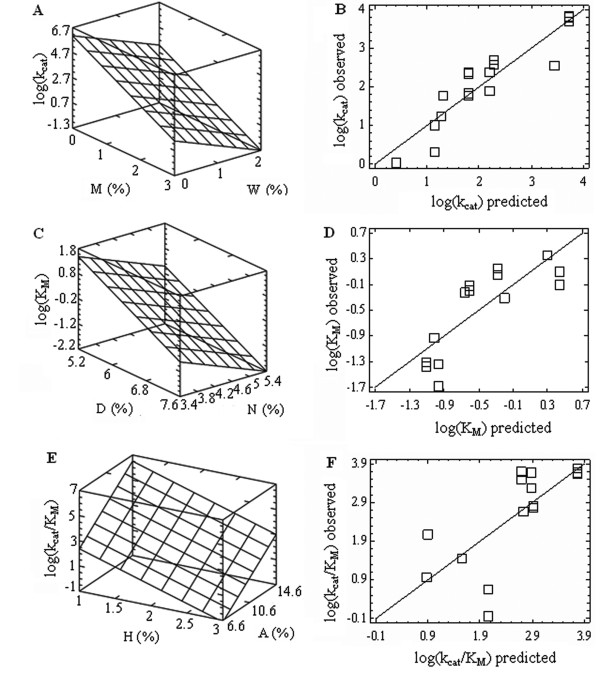
The relationships between kinetic constants and frequencies of two AA. The multiple linear regressions showing changes of the log-values of kinetic constants as dependent variables upon the frequencies of occurrence for two AA in the yeast S. cerevisiae sequences, where kcat is the catalytic constant (A), KM is the Michaelis-Menten constant (C), and ksp = kcat/KM is the specificity constant (E). The observed versus predicted plots (B,D,F) for the values of dependent variables (kcat, KM, and ksp, respectively). The predicted values were calculated from the regression equations: log(kcat) = 5.556 –1.620*M −0.984*W (Radj.2 = 82.88%, p = 0.0000); log(KM) = 8.593 –0.596*N −0.998*D (Radj.2 = 53.72%, p = 0.0039); log(kcat/KM) = 0.818 +0.501*A −1.736*H (Radj.2 = 46.50%, p = 0.0068). All the multiple and pair correlations (A–F) are significant at the non-parametric assessment (Kendall's τ, Spearman's ρ correlation coefficients).